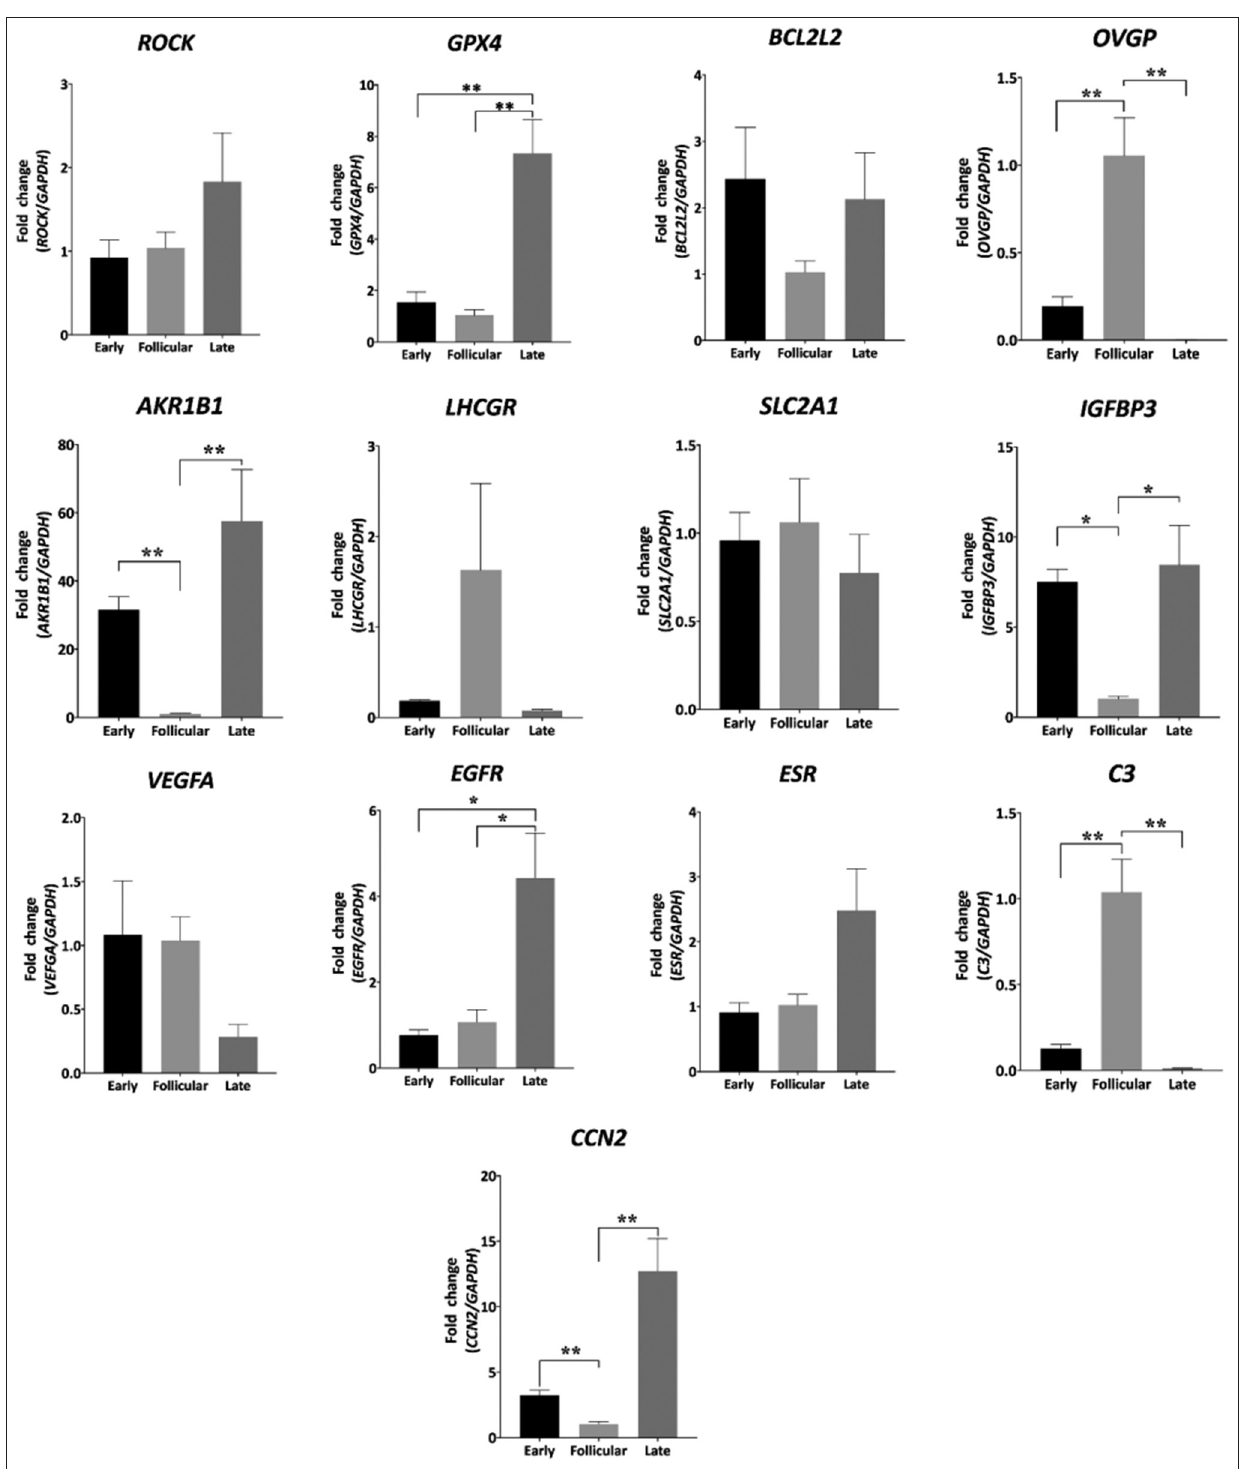
Figure-1: Gene expression patterns of different genes related to cytokinesis and mitosis mechanisms ( ROCK , rho- associated coiled-coil containing protein kinase; CCN , Cellular communication network), growth factors ( IGFBP3 , insulin- like growth factor-binding protein 3; EGFR, epidermal growth factor receptor; VEGFA , vascular endothelial growth factor A), antioxidants mechanisms ( GPX4, glutathione peroxidase 4), apoptosis ( BCL2, B-cell lymphoma 2), complement component ( C3 ), energetic metabolism ( AKRIB1 , aldose reductase gene family 1-member b1; SLC2A1 , solute carrier family 2, facilitated glucose transporter member 1), hormones receptors ( ESR , estrogen receptor; LHCGR , luteinizing hormone/ choriogonadotropin receptor), and specific glycoproteins ( OVGP , oviduct-specific glycoprotein) on oviduct ampulla, during different estrous cycle phases. Early: Early luteal phase, Late: Mid-luteal phase, Follicular: Follicular phase. Data are shown as mean ± SEM. *p < 0.05; **p < 0.01. SEM=Standard error of the